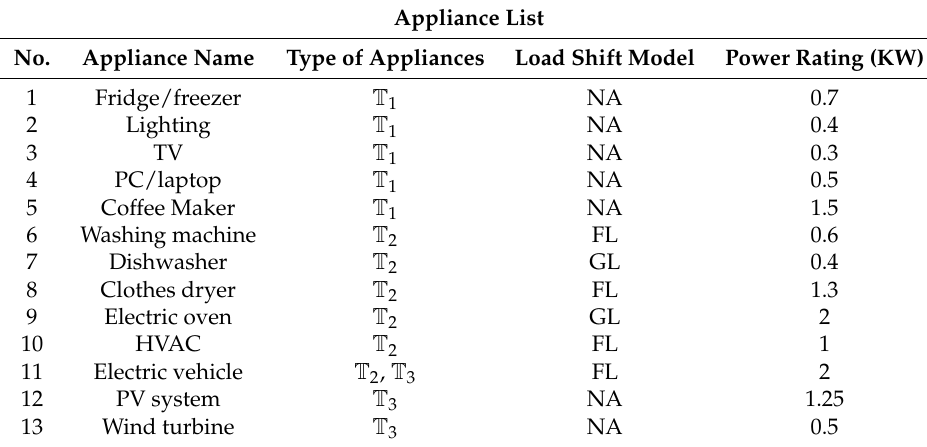
Table 1. List of Internet of Things (IoT)-based connected